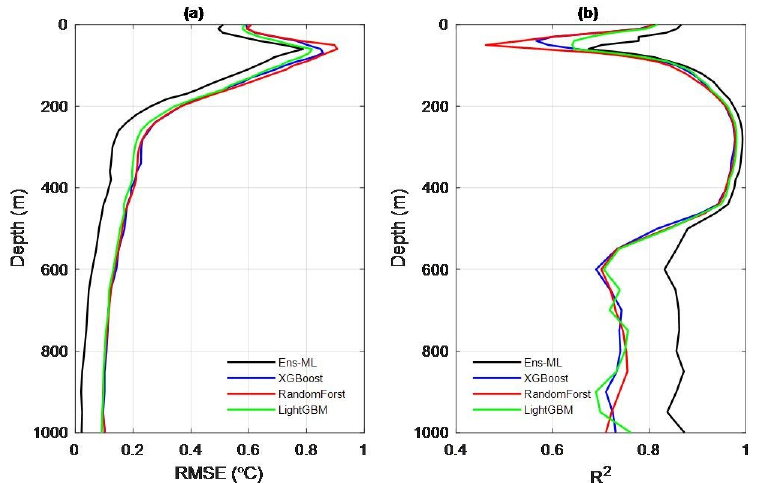
Figure 3. Comparison of the Ens-ML (black line) model with three individual machine learning models (XGBoost: blue line, RandomForst: red line, LightGBM: green line) for OSTS estimation at different depths based on ( a ) RMSE (°C) and ( b ) R 2 in 2019.